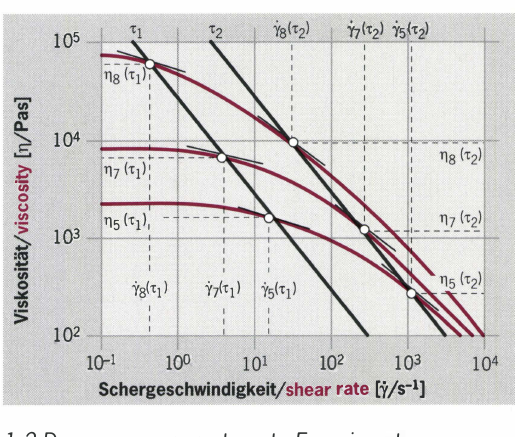
11 = 1,96 · lo4 Pa und 12 = 1,96. HJ5 Pa Fig. 3: Viscosity functions ll;IY of the Plexiglas types BH, 7N and 5N, ) together with two lines of constant shear stress 11 = 1.96 · lo4 Pa und 12 = 1.96 . lOS